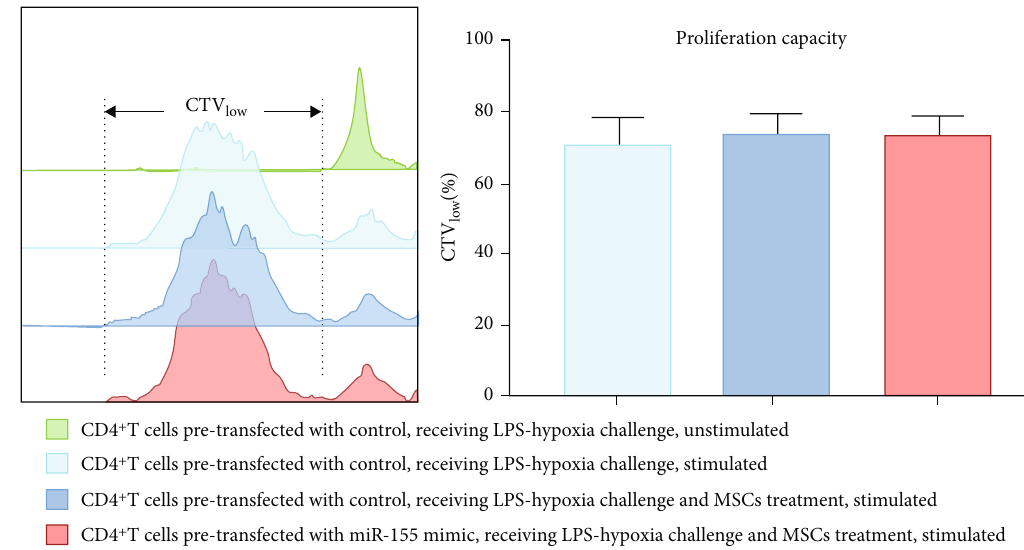
Figure 8: E ff ects of miR-155 overexpression in CD4 + T cells on proliferation capacity upon LPS-hypoxia challenge in response to MSC treatment. CD4 + T cells pretransfected with control/miR-155 mimic received MSC treatment by transwell system, with/without LPS- hypoxia challenge for 48 hours. Then, CD4 + T cells were sorted by positive CD4 selection, using CD4 microbeads and were labeled with CellTrace ™ Violet (CTV) reagent prior to stimulation with anti-CD3/CD28 antibodies. Cells unstimulated were set as controls (green). Proliferation capacity of CD4 + T cells was identi fi ed as CTV % by fl ow cytometry after 72-hour culture in vitro. Bar graphs represent low mean frequency ± SEM of proliferation capacity of CD4 + T cells in the various groups. LPS: lipopolysaccharide; MSC: mesenchymal stem cell; SEM: standard error of the